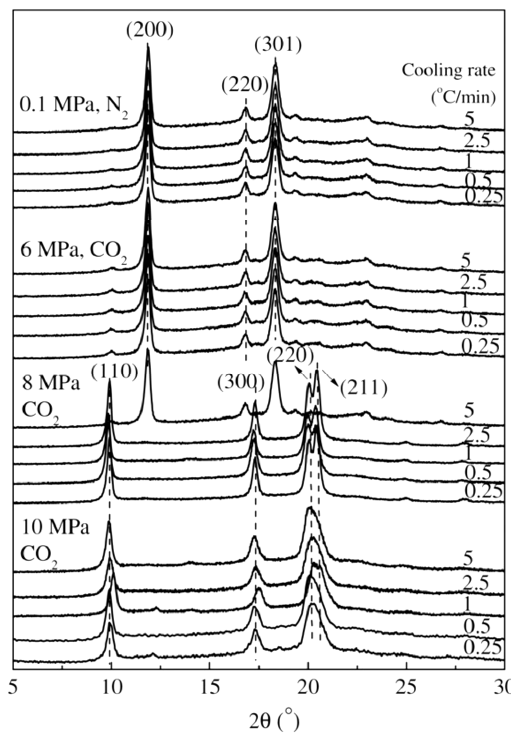
Figure 15. WAXD profiles of the iPBu melt-crystallized during cooling at different rates under varied conditions. Reproduced with permission from Ref. [91], copyright 2011 Elsevier Ltd.